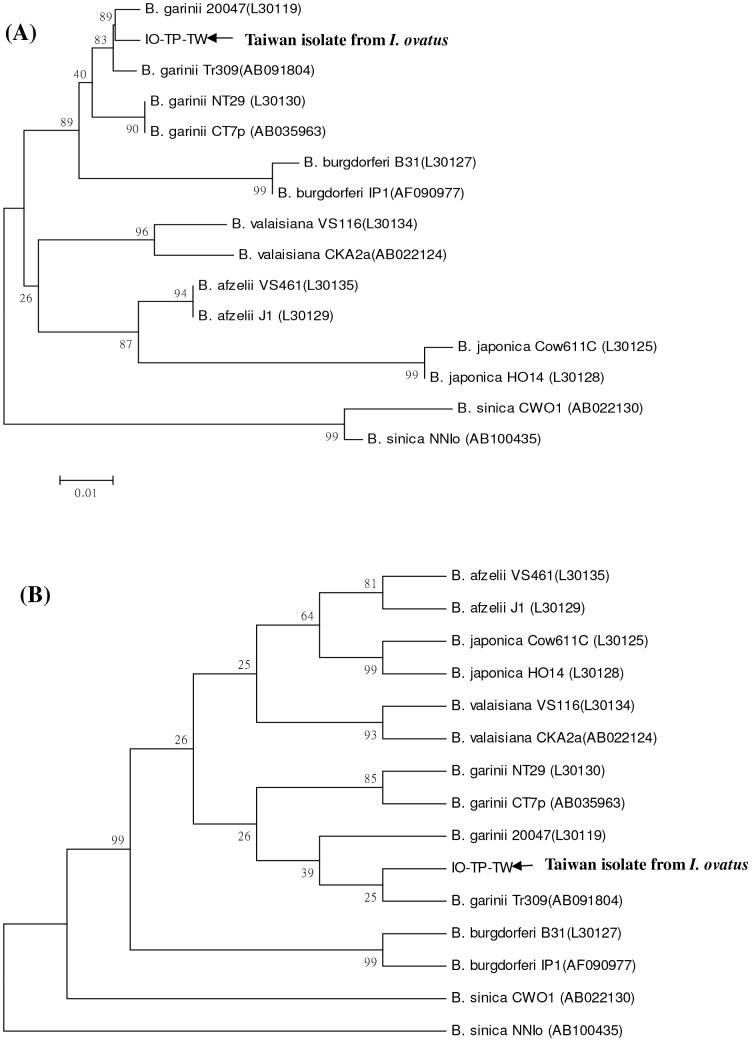
Phylogenetic relationships based on the 5S (rrf) –23S (rrl) rRNA gene sequences between Borrelia spirochete isolated from I. ovatus tick (strain IO-TP-TW) in Taiwan and 14 other strains belonging to six genospecies of Borrelia spirochetes.The trees were constructed and analyzed by (A) neighbour-joining and (B) maximum parsimony methods using 1000 bootstraps replicates. Numbers at the nodes indicate the percentages of reliability of each branch of the tree. Branch lengths are drawn proportional to the estimated sequence divergence.